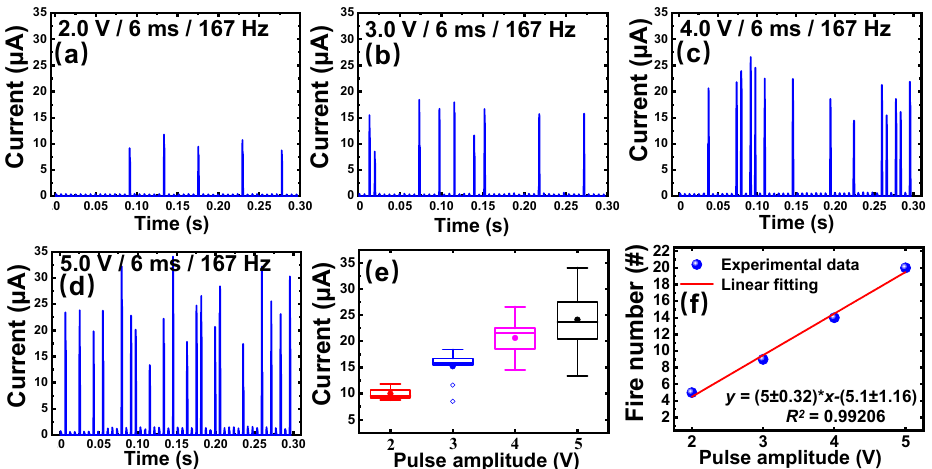
Figure 6. Output results of firing frequency influenced by the amplitude of the applied pulses. ( a – d ) Responses of firing frequency to impulse sequences with amplitude/width/frequency of (2.0 V/6 ms/167 Hz), (3.0 V/6 ms/167 Hz), (4.0 V/6 ms/167 Hz), and (5.0 V/6 ms/167 Hz), respectively. ( e ) Box chart of current response to input pulses with different amplitudes. ( f ) Plot and linear fitting of firing frequency related to programing input pulses with different amplitudes extracted from ( a – d ).